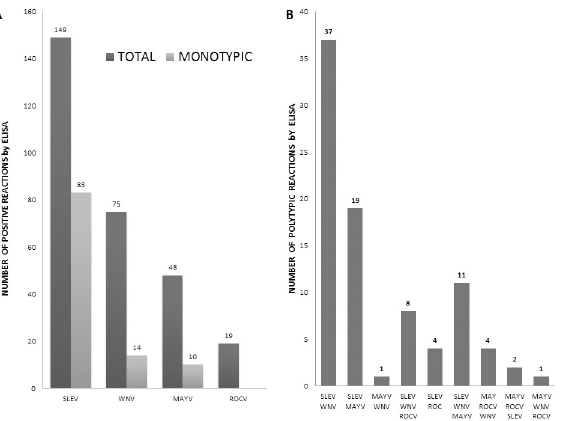
Fig 2. Positive ELISA assays for arboviruses in equines from the south of Roraima state. (A): Total positive results by ELISA and total monotypic (when reacting with only one of the viruses) reactions. (B): Polytypic (when reacting with two or more viruses) results for arboviruses by ELISA. SLEV: St. Louis encephalitis virus; WNV: West Nile virus; MAYV: Mayaro virus; ROCV: Rocio